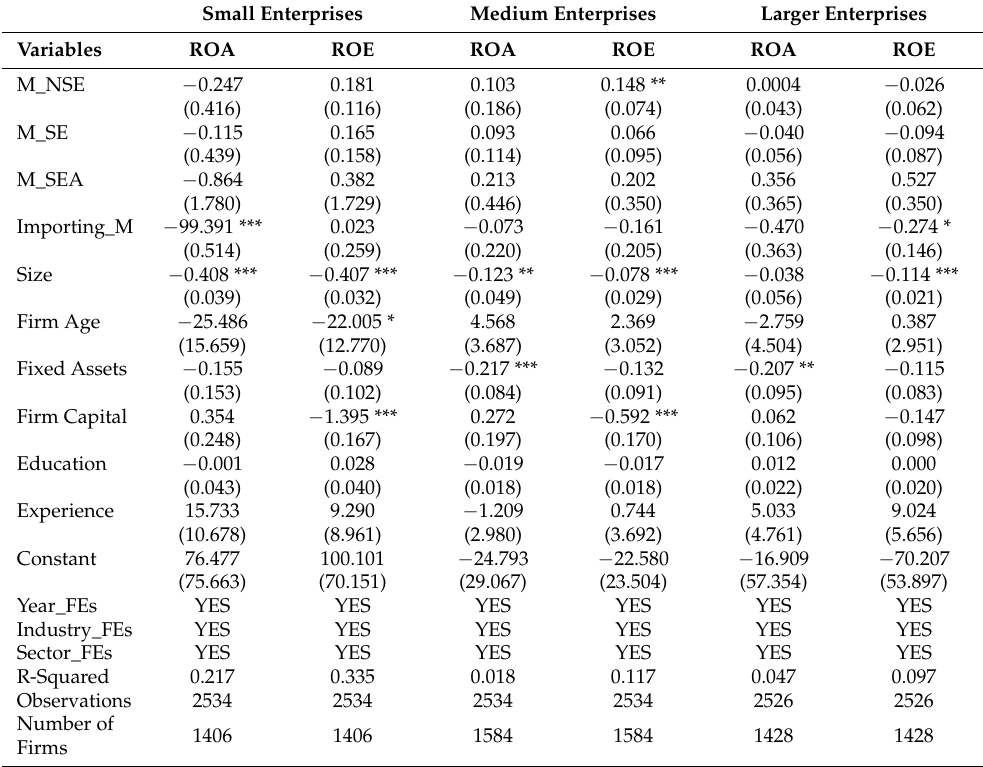
Table 7. Firm performance and raw materials classified by firm-size. Small Enterprises Medium Enterprises Larger Enterprises